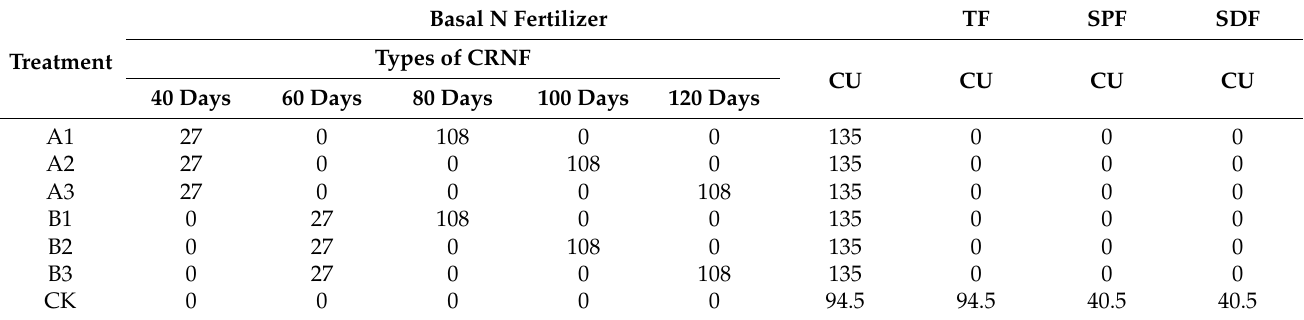
Table 1. Nitrogen fertilizer types and application amounts (kg ha − 1 ) and timing for different treatments.